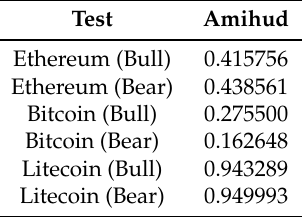
Table 6. Amihud illiquidity ratio on hourly returns for Ethereum, Bitcoin, and Litecoin during bull and bear